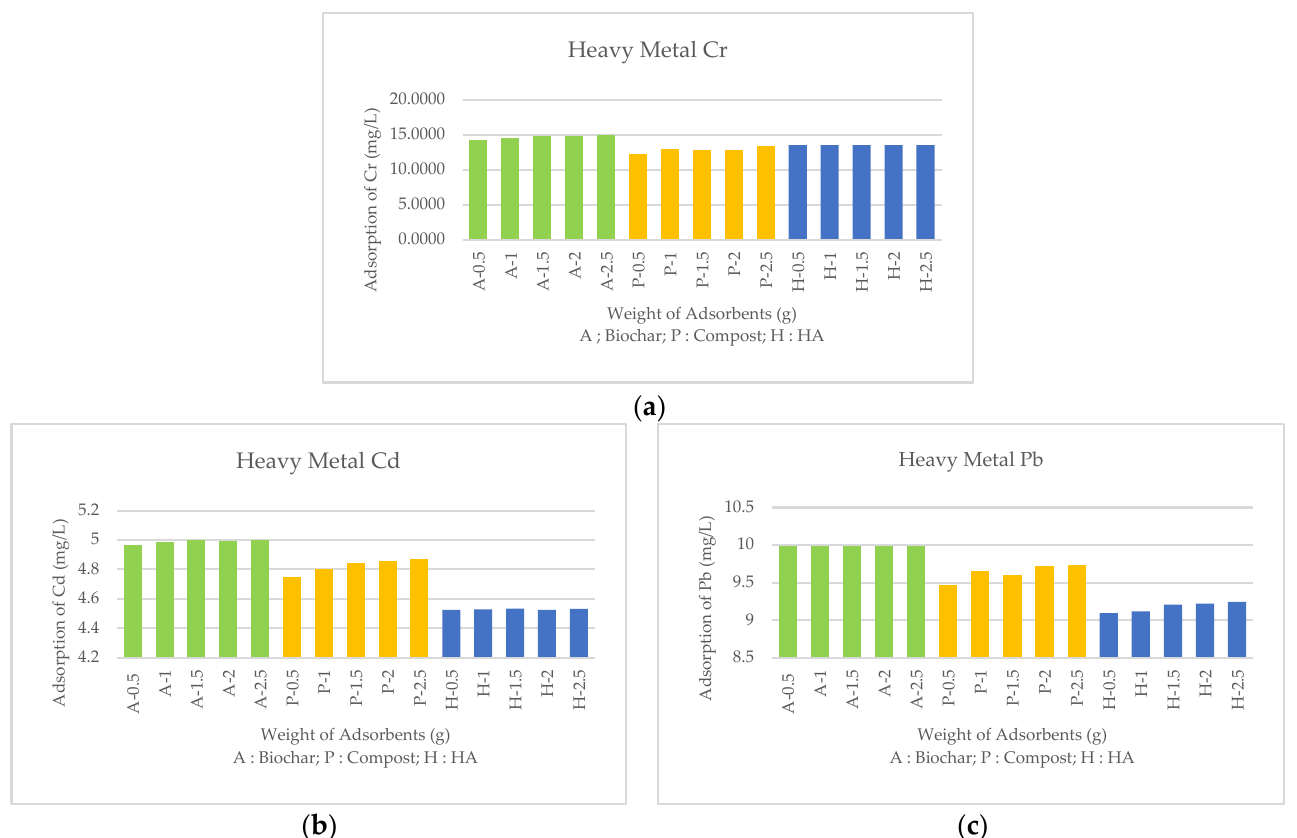
Figure 4. The adsorption of heavy metals Cr ( a ), Cd ( b ) and Pb ( c ) at various weights of adsorbent. The adsorption of heavy metals at varied contact times during each 120 min treatment is depicted in Figure 5 (biochar, composts and humic acids).